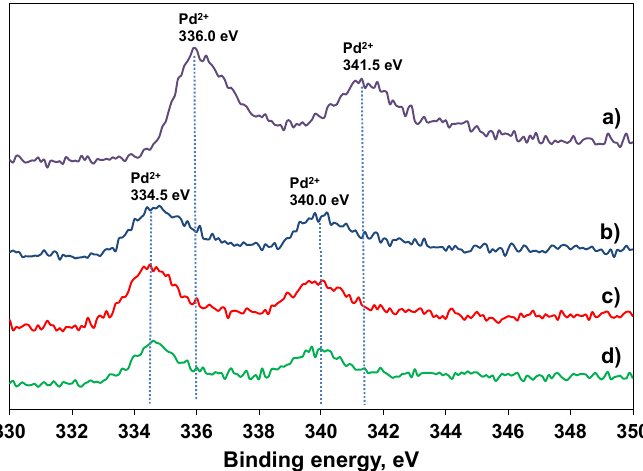
Figure 4. X-ray photoelectron spectroscopy (XPS) spectra of Pd3d for 2Pd-CZA catalysts: ( a ) unreduced fresh catalyst; ( b ) reduced fresh catalyst; ( c ) unreduced spent catalyst; ( d ) reduced spent catalyst. CZA: Cu/Zn/Al (molar) = 35/35/30. All traces have been displaced for clarity.